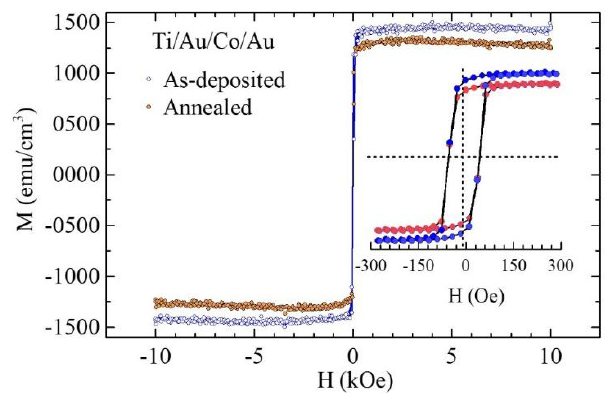
Figure 3. Magnetization (M-H) characteristics of the as-deposited (denoted by blue circles) and annealed (denoted by red circles) samples plotted against the magnetic, H field. The inset shows the enlarged view of the M-H curves measured at H ± 300 Oe.